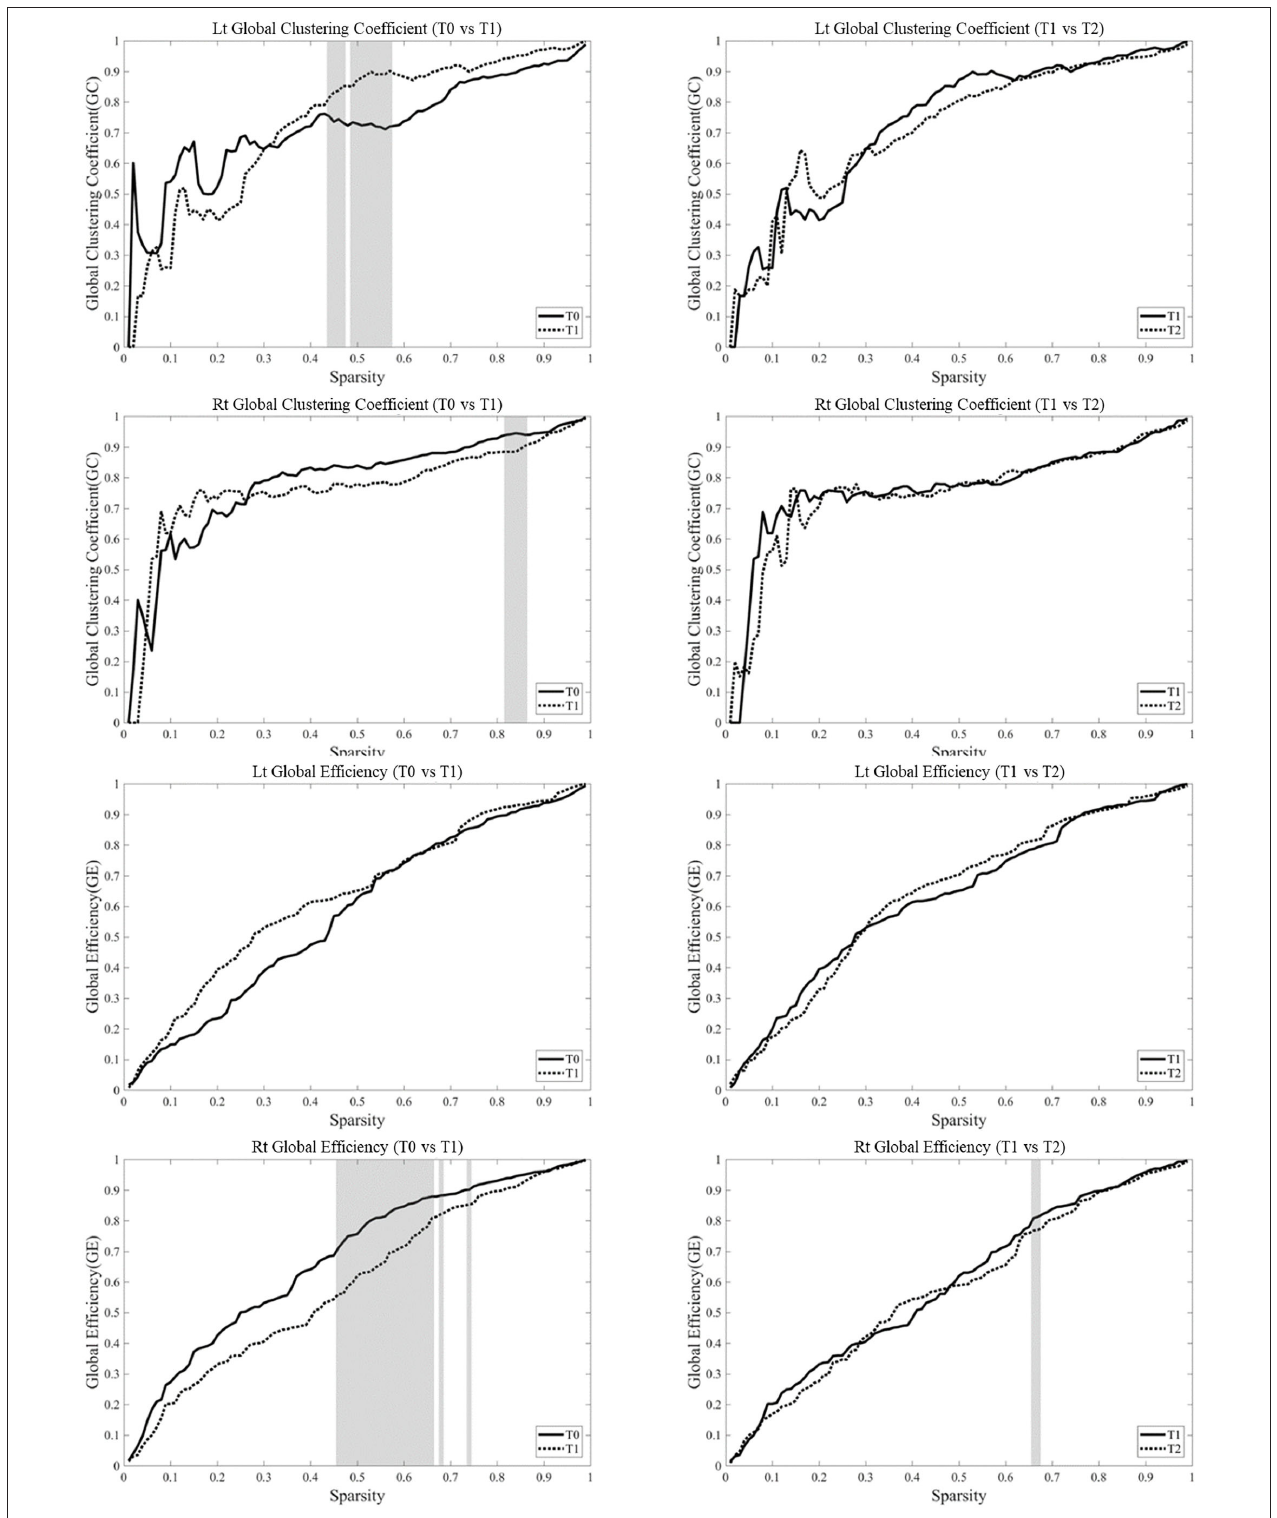
FIGURE 6 | Network parameters were based on the task-based functional networks generated from the measurements of changes in oxyhemoglobin (OxyHb) over the whole range of sparsity. Analysis of the changes in parameters from T0 to T1 in each hemisphere showed that the clustering coefficients of the left hemisphere